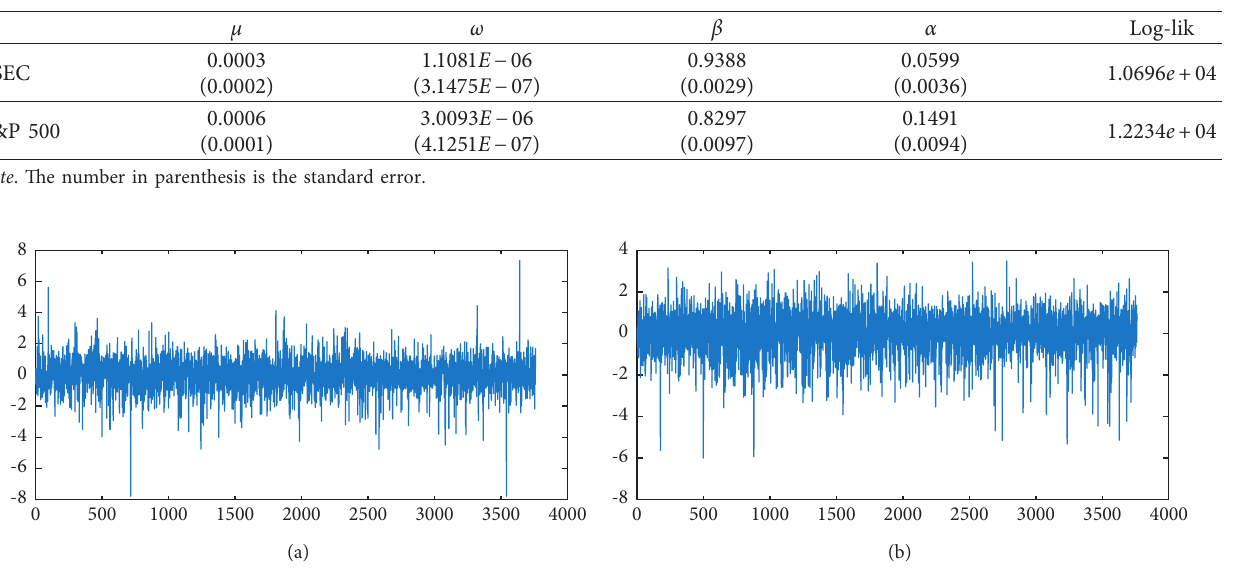
and z . (a) QQ plot of z 1 t . (b) QQ plot of z 2 t . 1 t 2 t